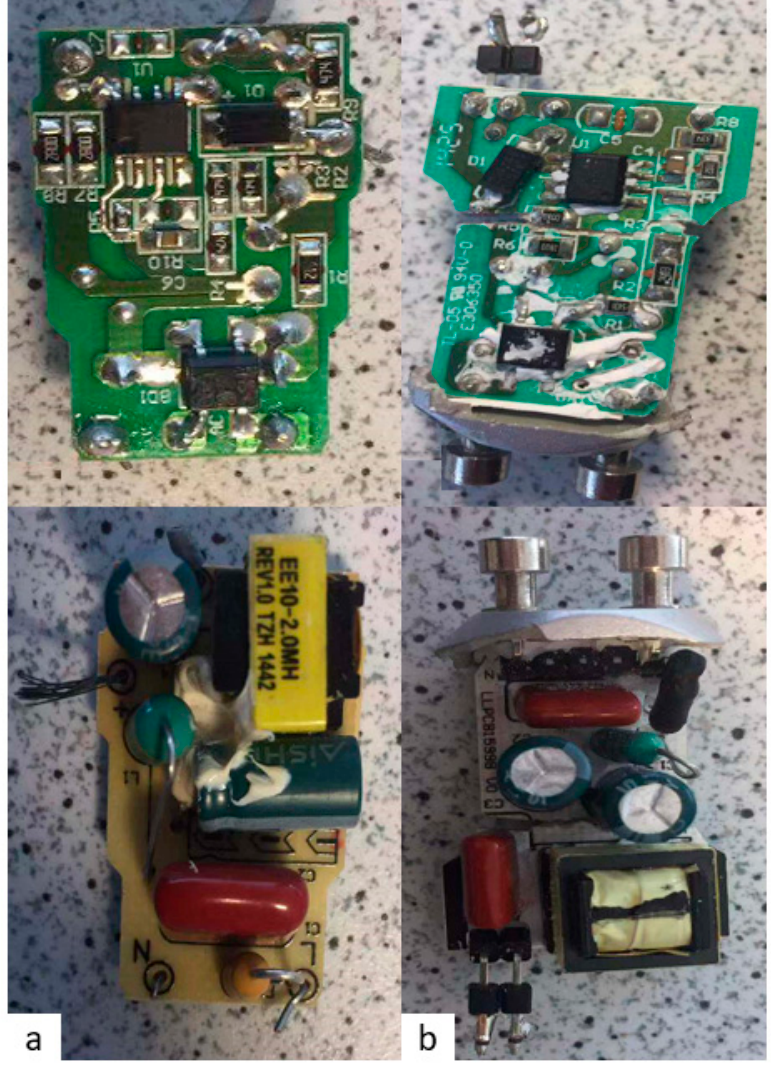
Figure 3. The two sides of both drive circuits after disassembly. Circuit boards of sample A on the left ( a ) and sample B on the right ( b ); top row: sides with tracks and ICs, bottom row: sides with discrete electrical components.